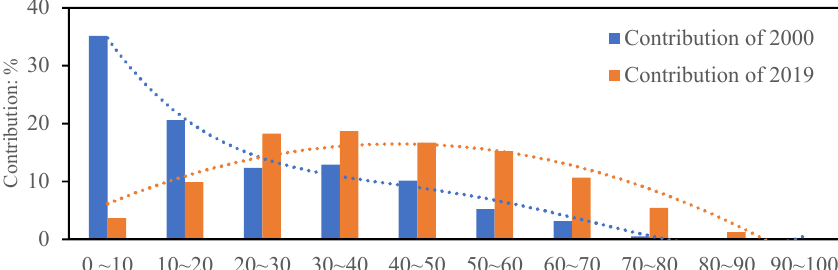
Figure 6. Area changes of different levels of FVC in YRB between 2000–2019. According to the contribution of each interval to the vegetation increase, regions with higher contributions to the vegetation increase were regions which originally had low FVC. In 2019, the contribution of FVC in the range of 20–60% was 68.90%. The region with the highest contribution had an FVC value of 30–40%. In 2000, the regions with the greatest contribution had FVC values between 0% and 10%, and a contribution of 35.13% (Figure 7).